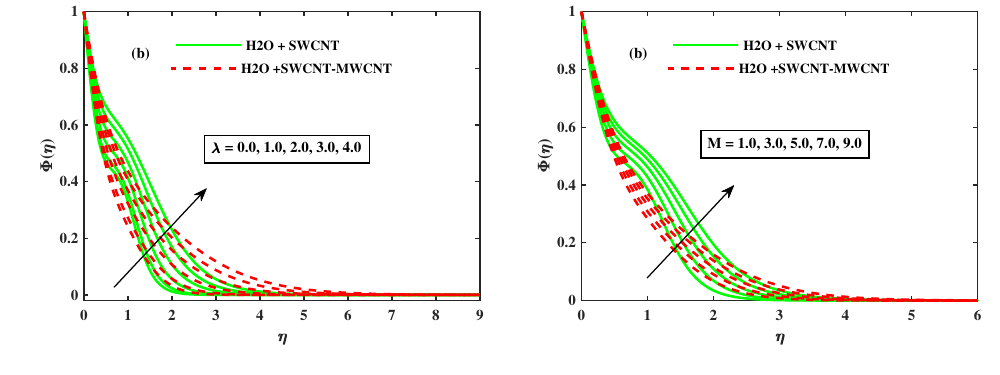
Figure 6. Effect of λ and M on Φ ( η ) .